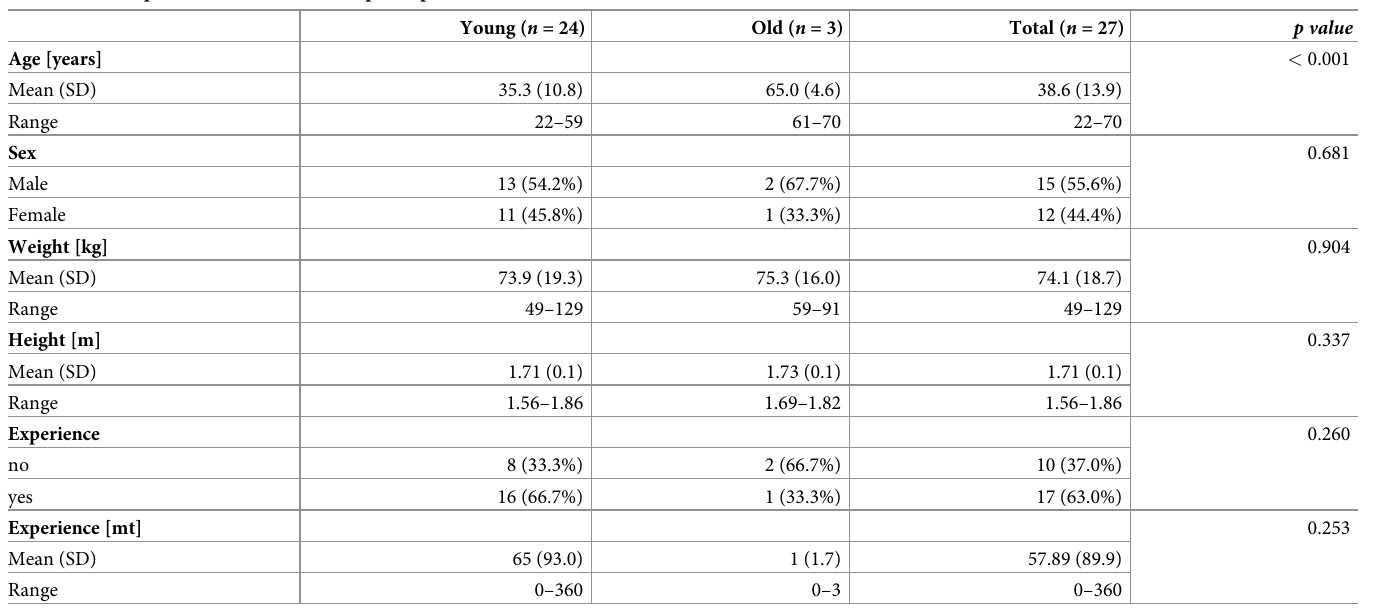
Table 1. Anthropometrical information of